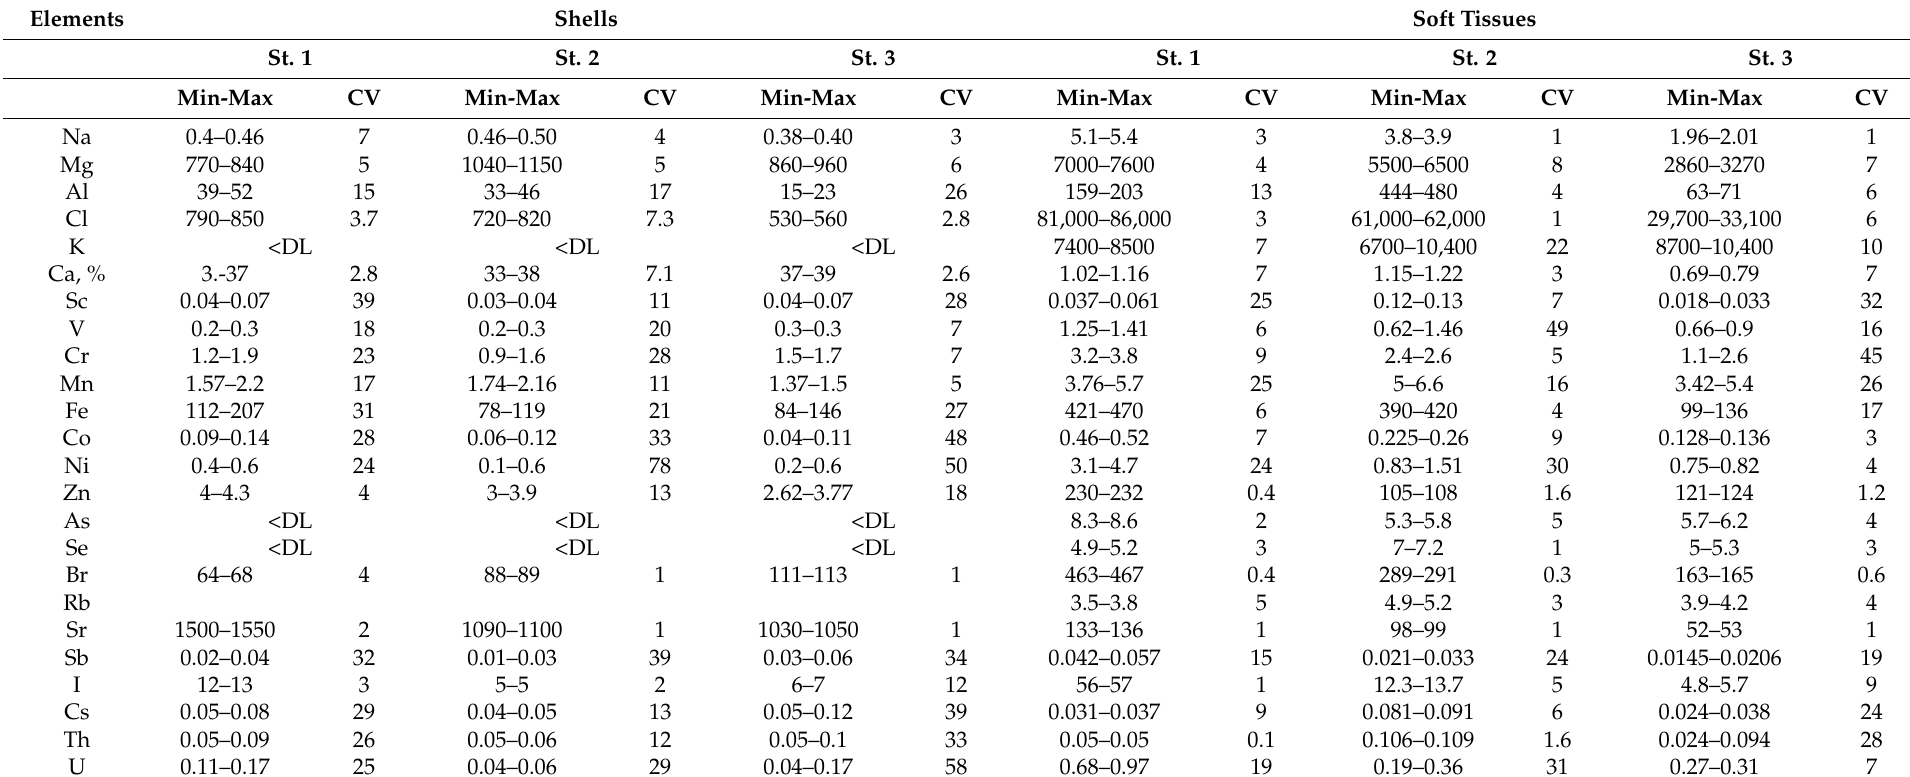
Table 2. The ranges of concentrations of elements in shells and soft tissues of Mytilus galloprovincialis in the Saldanha